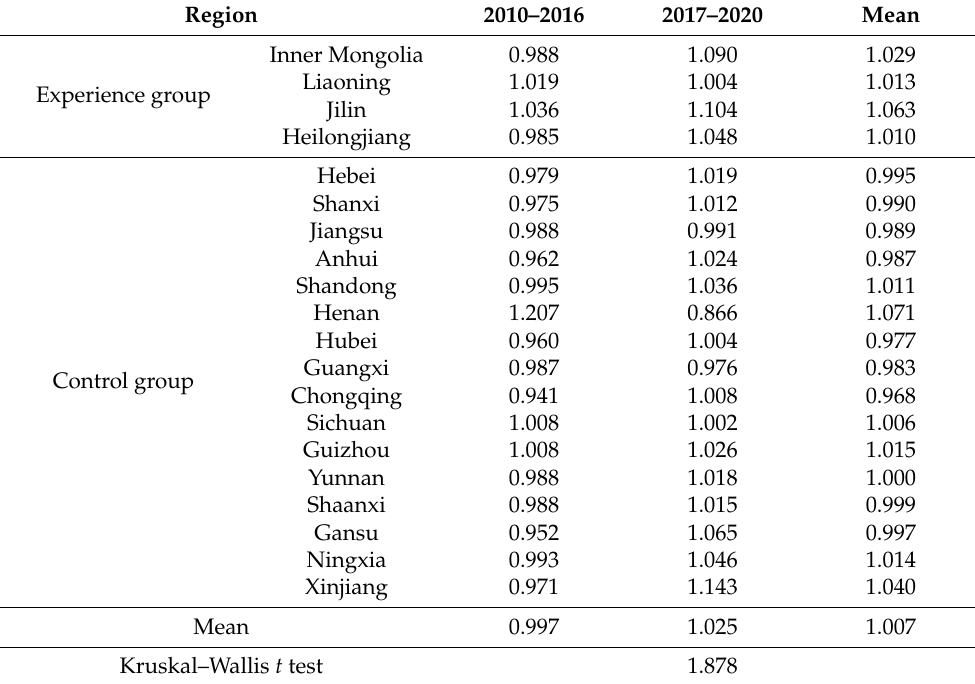
Table 3. Measurement results of China’s MGTFP.